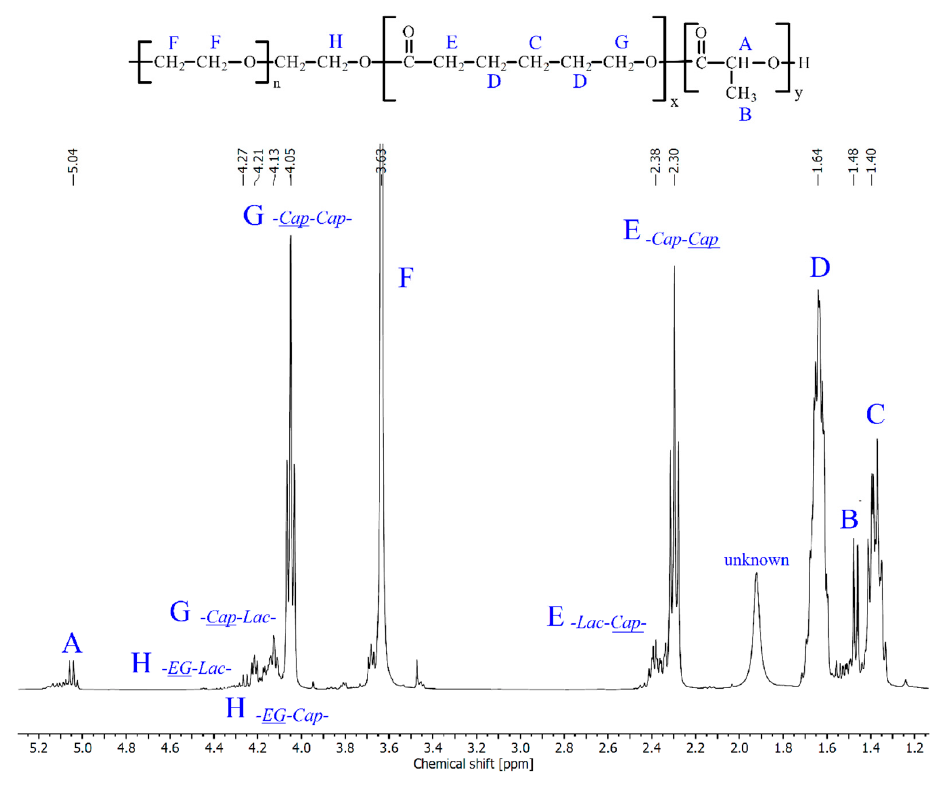
Figure 1. The PCLA synthesis via the ROP process.